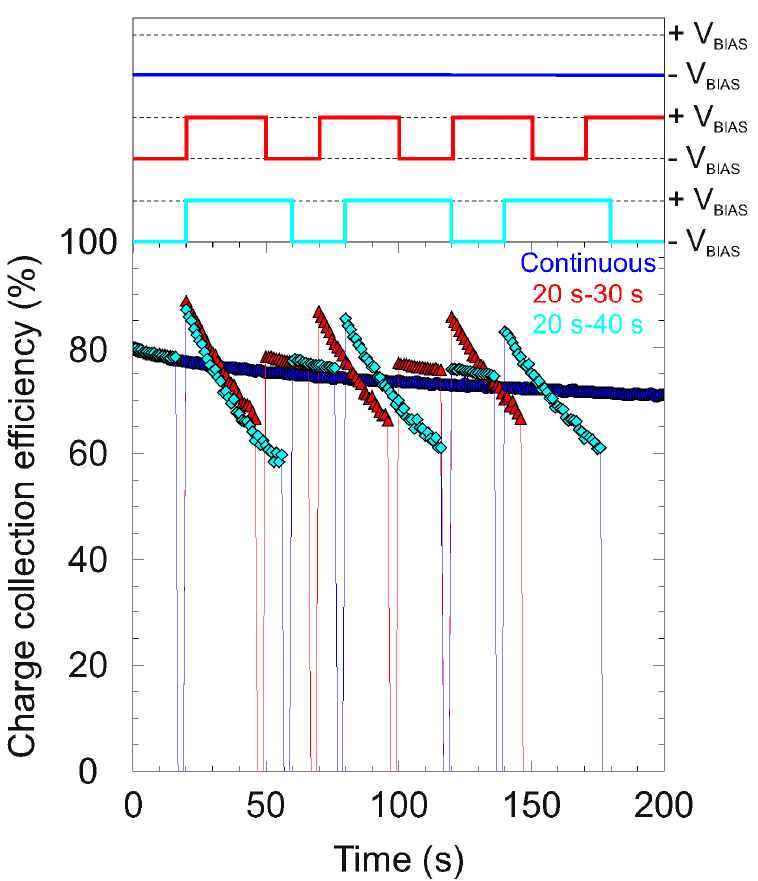
Figure 11. ( top ) Chronogram of the applied polarities; ( bottom ) temporal evolution of the CCE using alternating bias for different duty cycles. The temporal evolution under normal conditions (blue points) is also included for comparison.